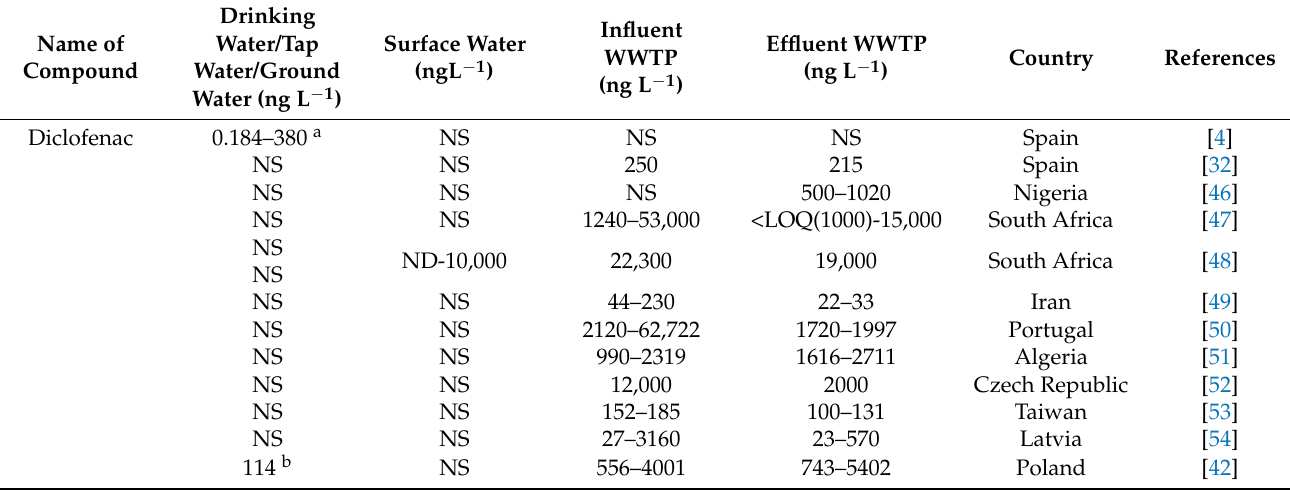
Table 2. Occurrence of selected NSAIDs in water bodies (surface water, effluent WWTP, influent WWTP, effluent